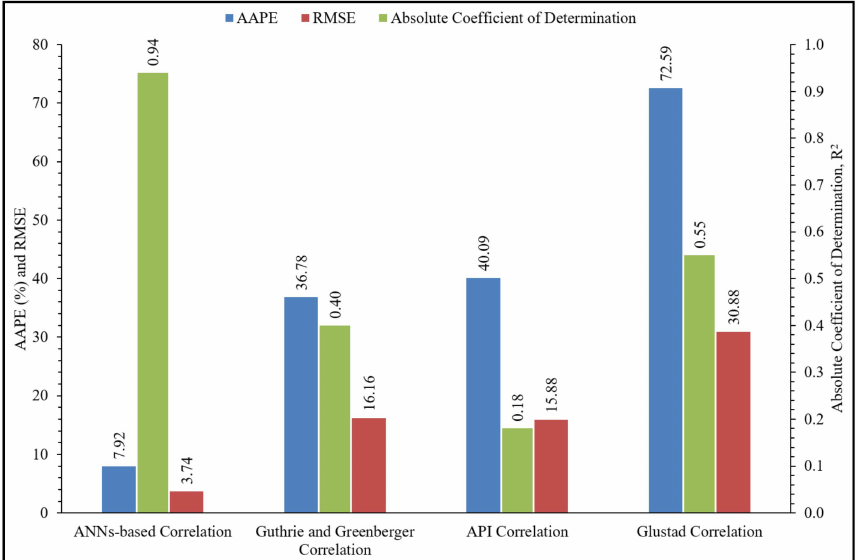
Figure 7. Comparison of AAPE, root mean square error (RMSE), and R 2 of ANNs-based, Guthrie and Greenberger, API, and Gulstad correlations for the testing